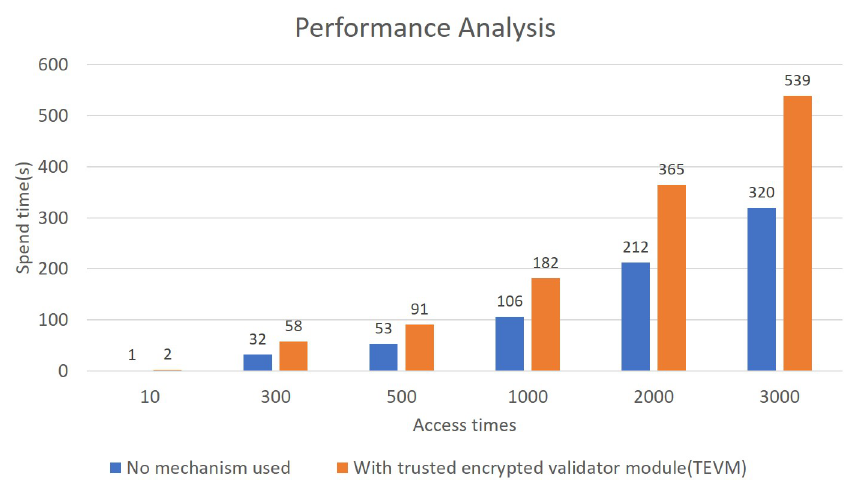
Figure 13. The performance analysis of